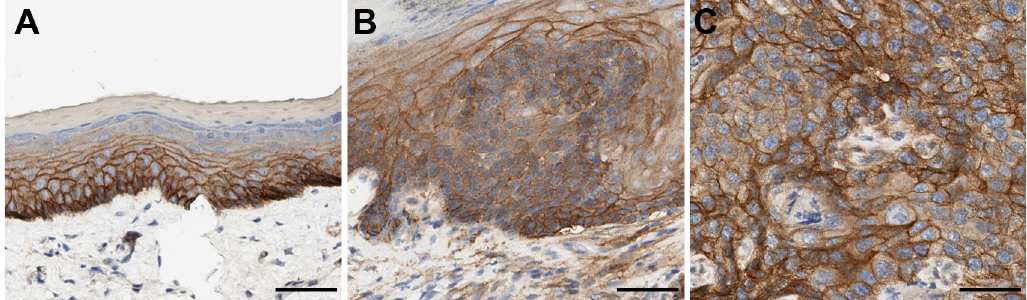
Fig 6. High EGFR expression in DBPDE-treated mice. (A) EGFR expression in normal epithelia is highest in the basal layer and decreases as cells become more differentiated and superficial. (B) EGFR expression is high in hyperplastic and dysplastic epithelium. (C) EGFR expression is high in invasive cancers. n = 15. � p < 0.05.